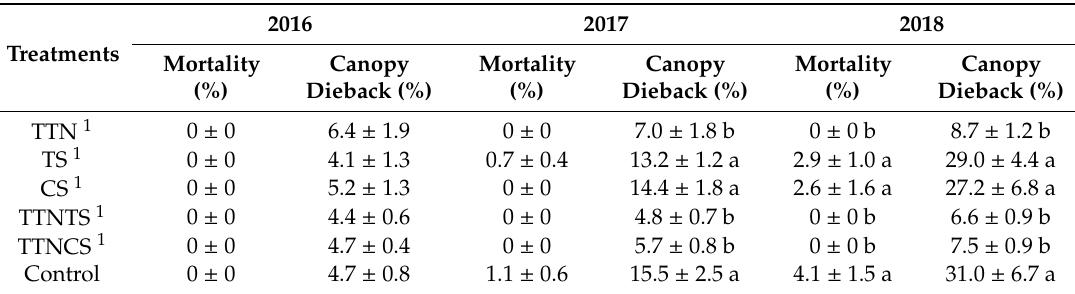
Table 3. The tree-of-heaven weevil (TRW), Eucryptorrhynchus scrobiculatus, damage (means ± SE, expressed as a percentage) to tree-of-heaven Ailanthus altissima at Haojiaqiao, Lingwu city of Ningxia, China (2016–2018). Means followed by di ff erent letters within the same column are significantly di ff erent (Kruskal–Wallis test, α =